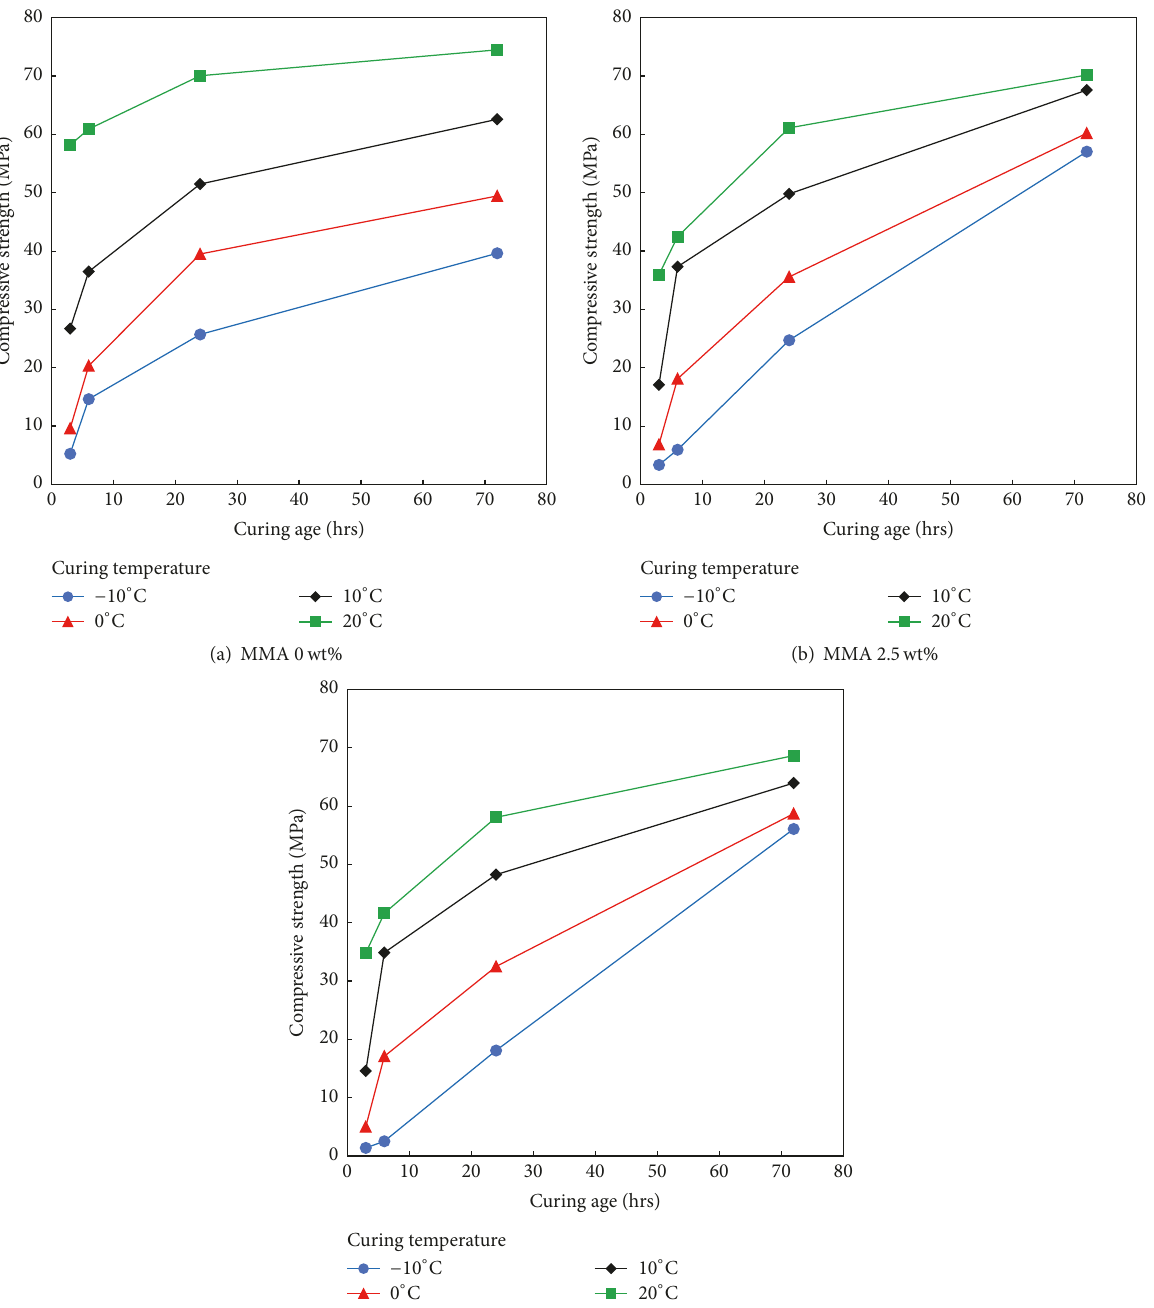
Figure 1: Curing age versus compressive strength with curing